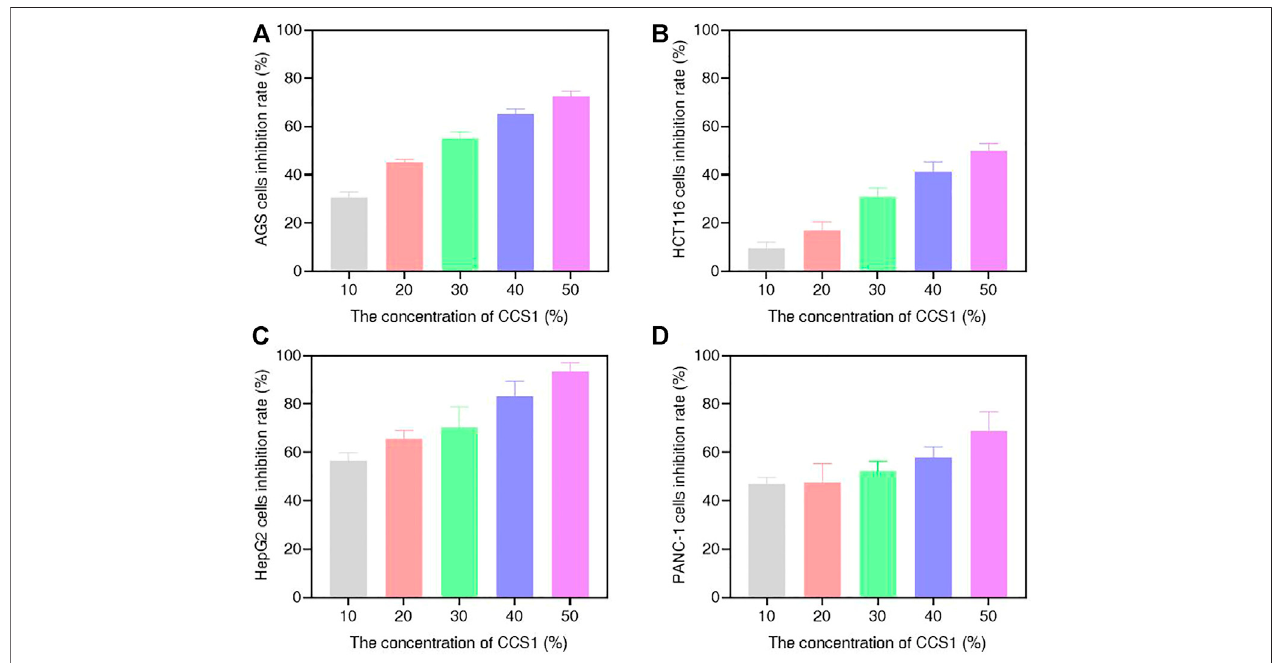
FIGURE1| SuppressiveeffectofCCS1ontheproliferationoffourkindsofdigestivetractdigestivetractcancercells.Theresultswereobtainedaftertreatmentwith CCS1 for 48 h (A – D) CCK-8 results for AGS, HCT116, HepG2 and PANC-1 cells. Data are expressed as the average of three independent experiments.